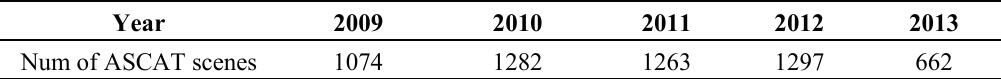
Figure 3. Wind field retrieved from ASCAT data for 2 March 2011 at 01:46 UTC. Table 2. ASCAT data used in the study per